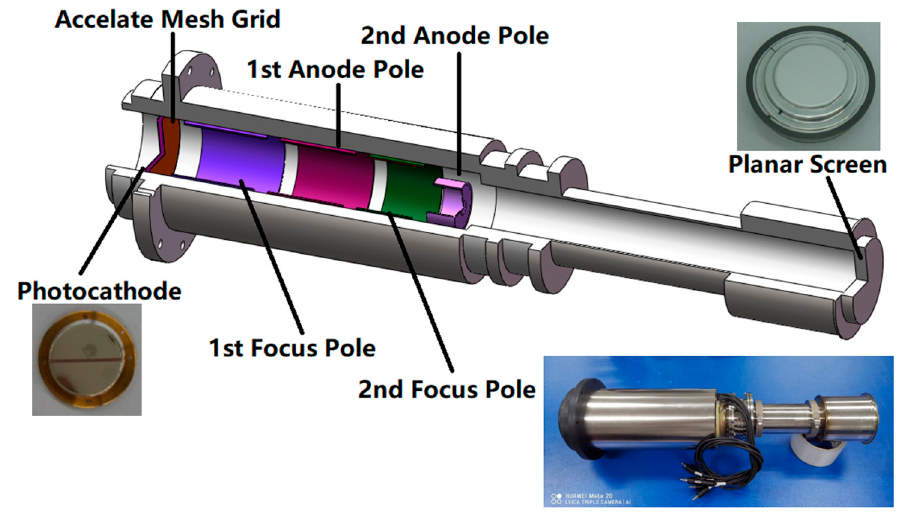
Figure 2. Structural diagram of streak tube used in the test. Table 1. Structural parameters of streak tube.